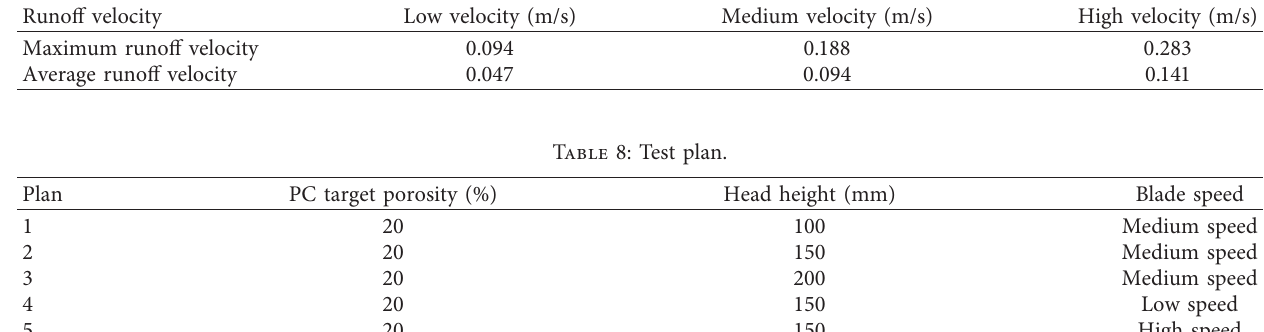
Table 7: Maximum runoff velocity and average runoff velocity produced by each rotation speed.